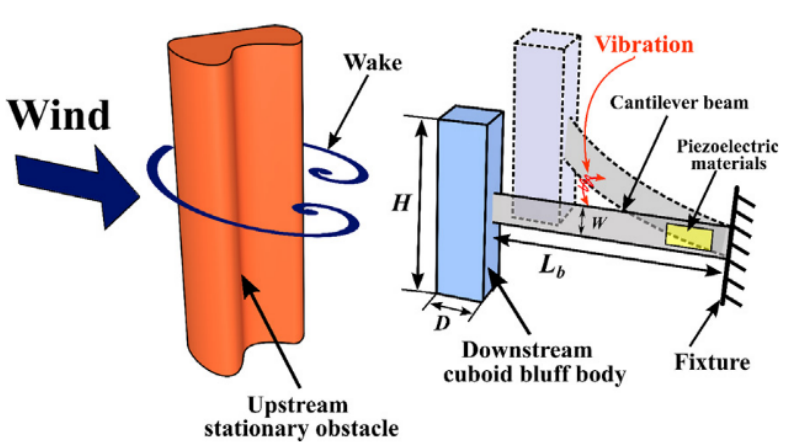
Figure 13. Schematic of wake galloping in a piezoelectric energy harvester [267].